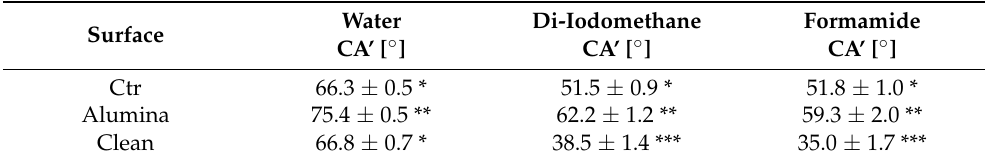
Table 2. Apparent contact angles for the three liquids used on the different c.p. Ti surfaces. Values are mean ± standard deviation. Statistical differences vs. smooth surfaces for each column are indicated by single and double or triple asterisk symbols ( p < 0.05).